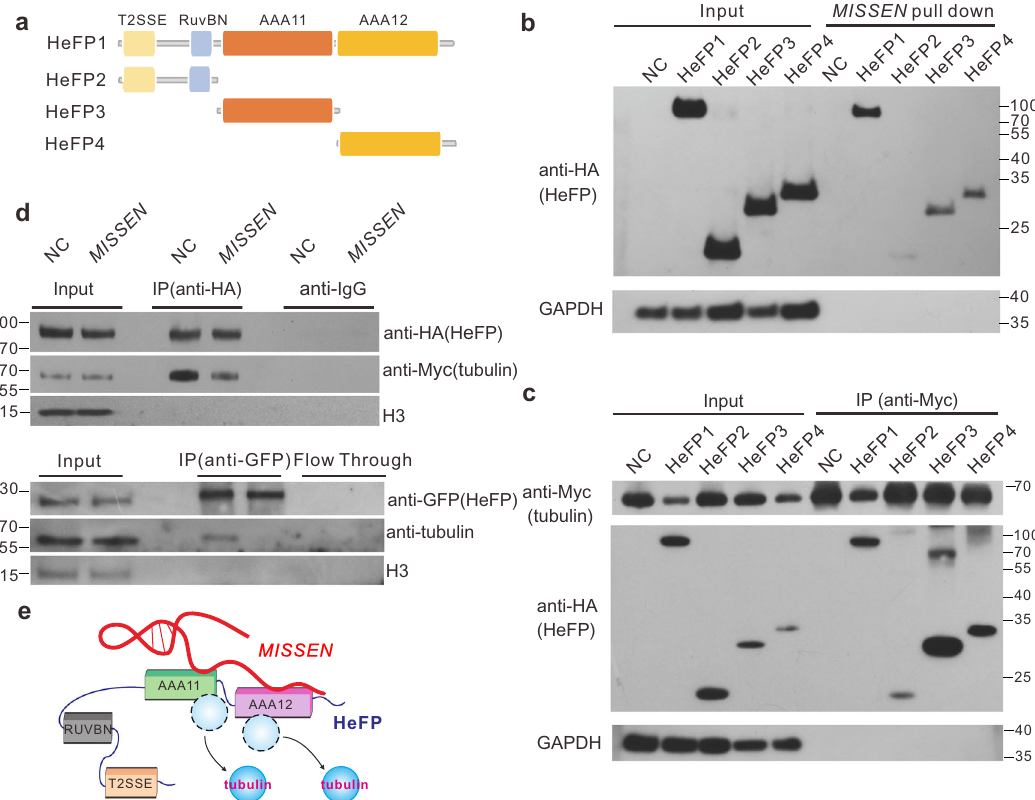
Fig. 6 MISSEN competitively inhibited the interaction between HeFP and tubulin. a HeFP sections used for binding domain identi fi cation. b Identi fi cation of the MISSEN binding domain by a MISSEN pull-down assay. The experiment was repeated three times with similar results and one representative result was shown. c Identi fi cation of the tubulin binding domain by immunoprecipitation. The experiment was repeated three times with similar results and one representative result was shown. d In vitro competitive binding assay of MISSEN in rice protoplast cells generated from WT (up panel) and HeFP -OX (down panel, detecting inherent tubulin) seedlings. The experiment was repeated three times with similar results and one representative result was shown. e The schematic diagram that MISSEN inhibited the interaction between HeFP and